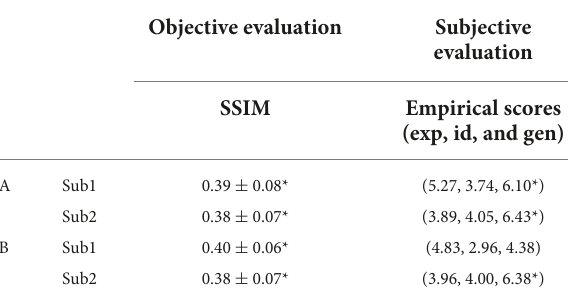
TABLE 5 Quantitative evaluation of seen (A) and unseen (B) face images reconstruction from intra-subject functional magnetic resonance imaging (fMRI)